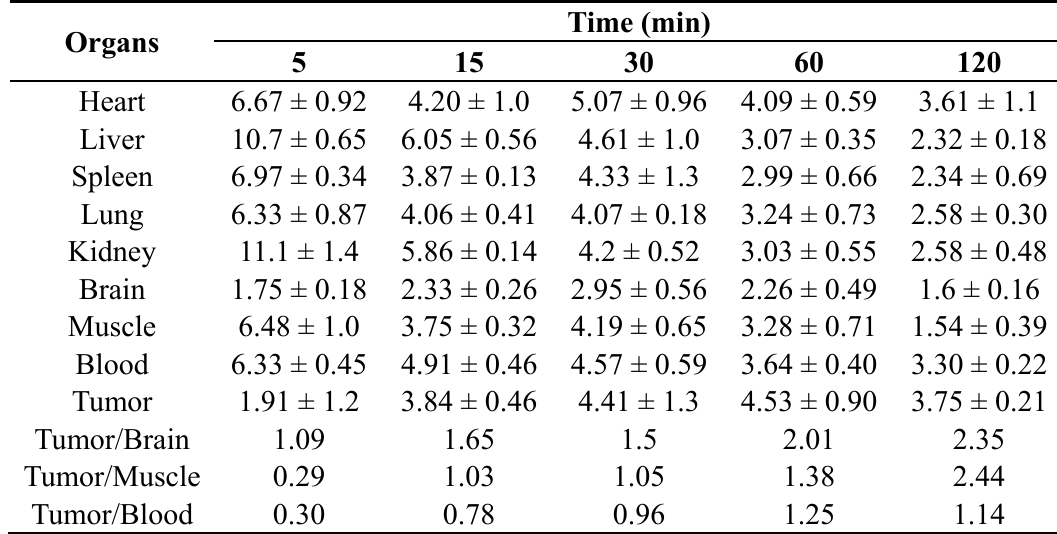
Table 2. Biodistribution of [ 18 F] 4 in mice bearing S 180 tumor. Expressed as % injected dose per gram (% ID/g ± SD), n = 4.